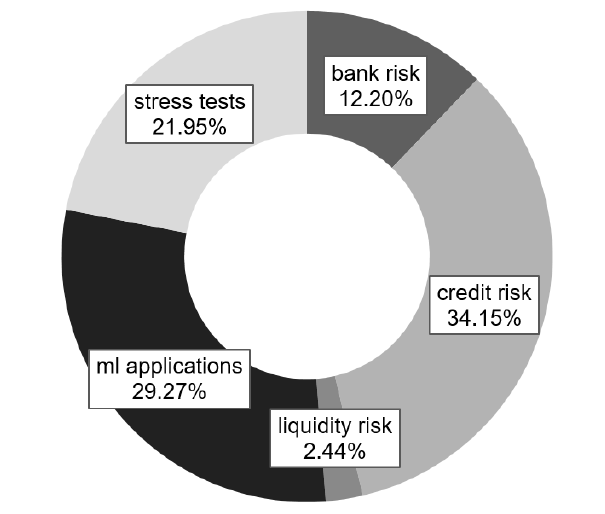
Figure 2. Distribution of articles according to main topic.